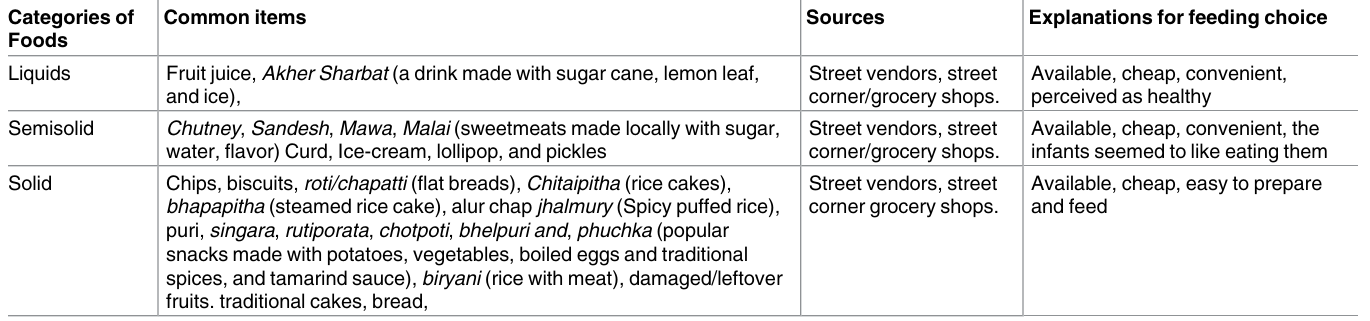
Table 4. Consumption of processedfood by IYC in the last 24 hours of interview. Categories of